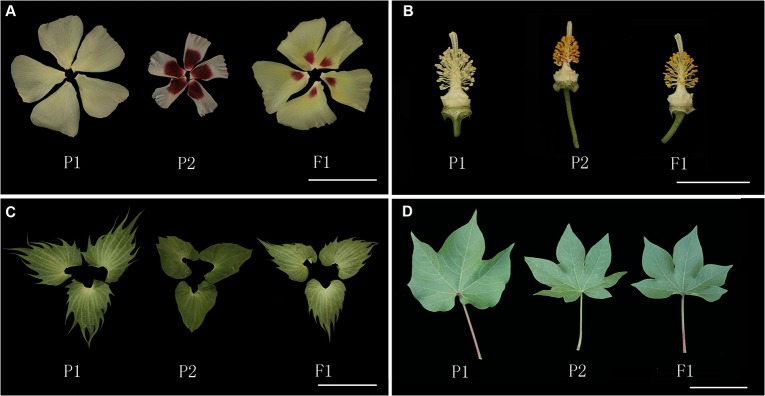
Morphology of G. hirsutum, G. arboreum and F1 hybrids.A, Petals; B, Pistils and stamens; C, Bracts; D, Leaves. Scale bars, 50 mm